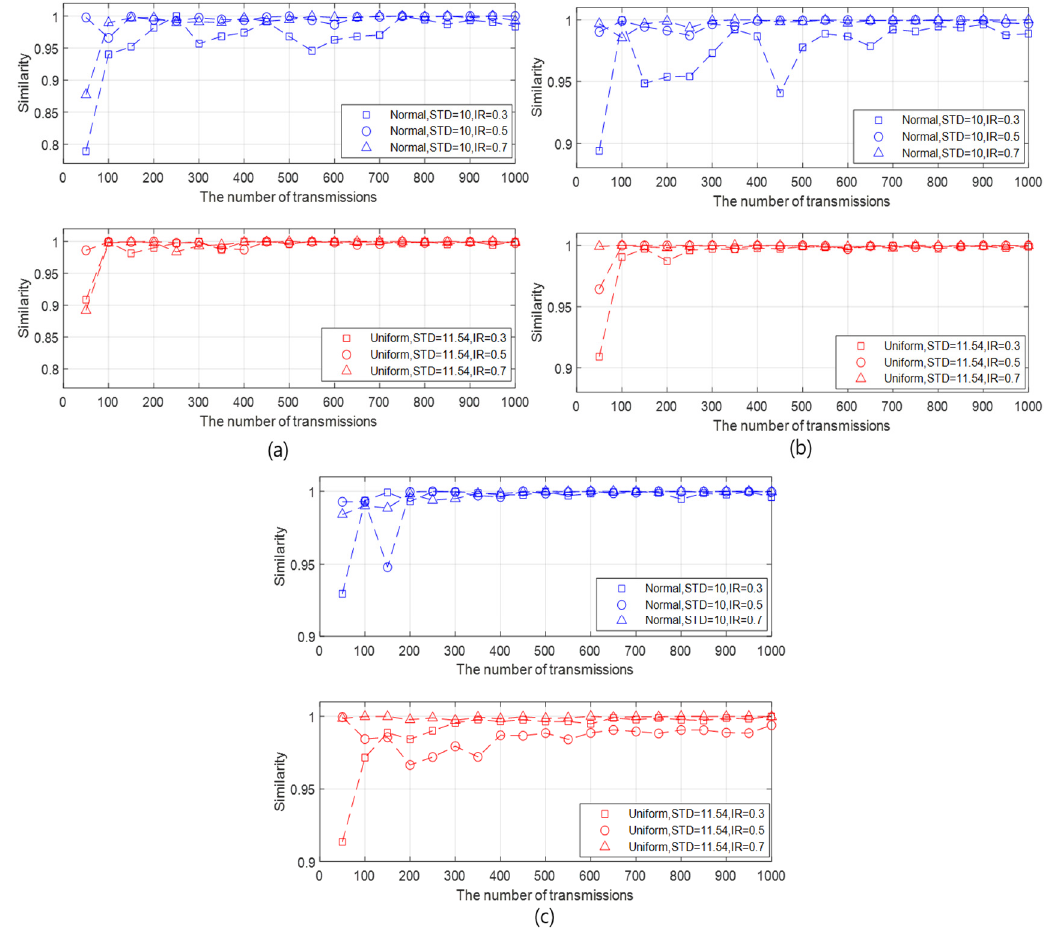
Figure 6. Similarities according to the number of transmissions for different data types, initialization rates, and amounts of slave nodes when the STD of the generated data with normal distribution and that with uniform distribution are, respectively, 10 and 11.54, and the BER is 10 − 3 . ( a ) The number of slave nodes = 10. ( b ) The number of slave nodes = 30. ( c ) The number of slave nodes = 50.